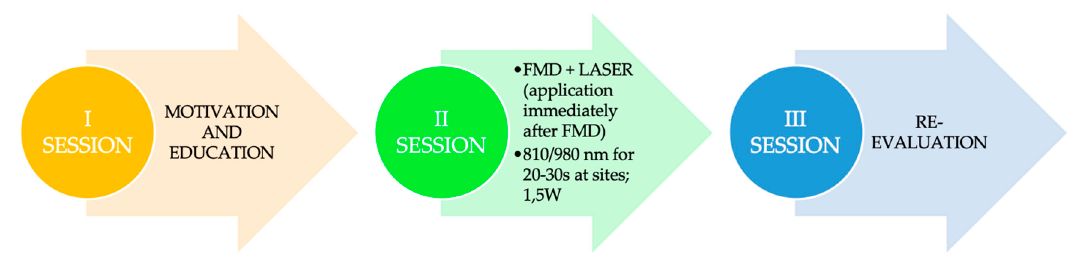
Figure 4. Laser as an adjuvant to the modified full mouth disinfection protocol. FMD: Full mouth disinfection; 1.5 W: 1.5 Watt.